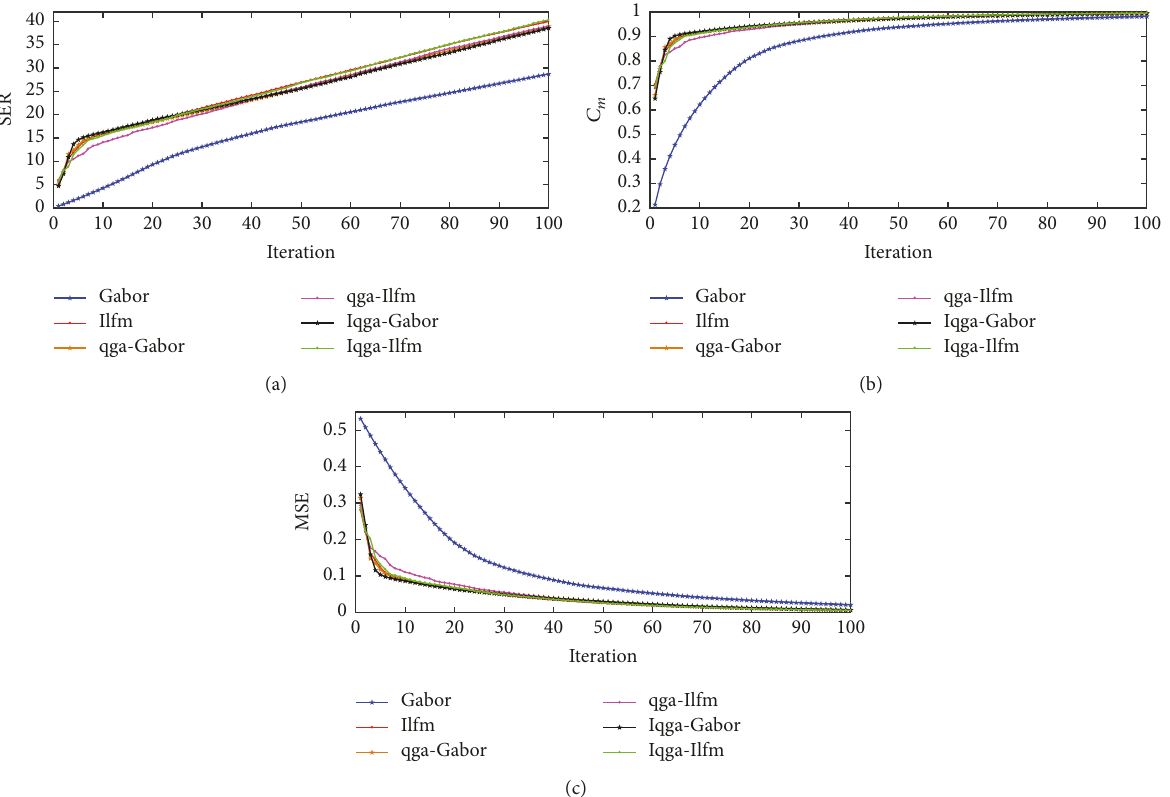
Figure 2: Simulated signal analysis results: Gabor dictionary and Ilfm dictionary are used to match the simulated signal 100 times in the OMP algorithm, the combinations of the QGA and the OMP algorithm, and the combinations of the IQGA and the OMP algorithm: (a) SER is changedwiththeiterations(thehighervalueshowsthefasterdecomposition),(b) 𝐶 𝑚 ischangedwiththeiterations(thecloservalueto1shows the better reconstruction of signal), and (c) MSE is changed with the iterations (the lower value shows the more stability of decomposition and reconstruction).